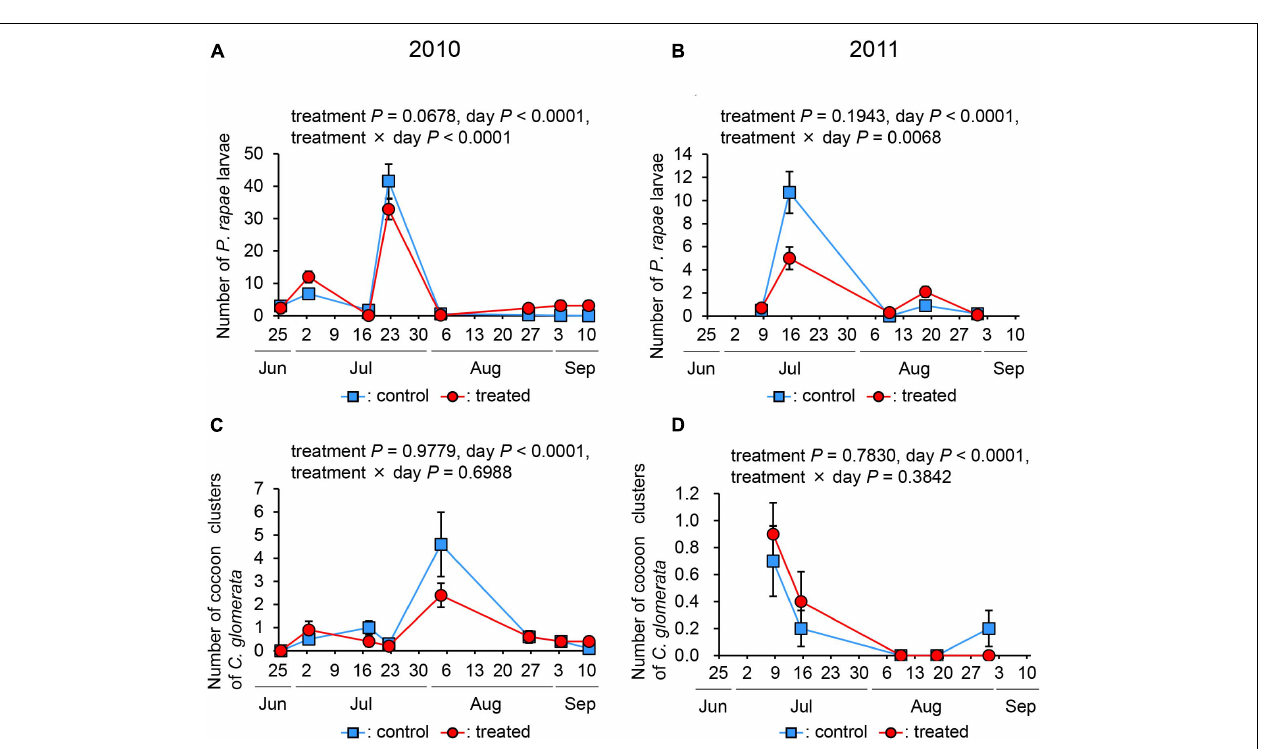
Frontiers in Ecology and Evolution |